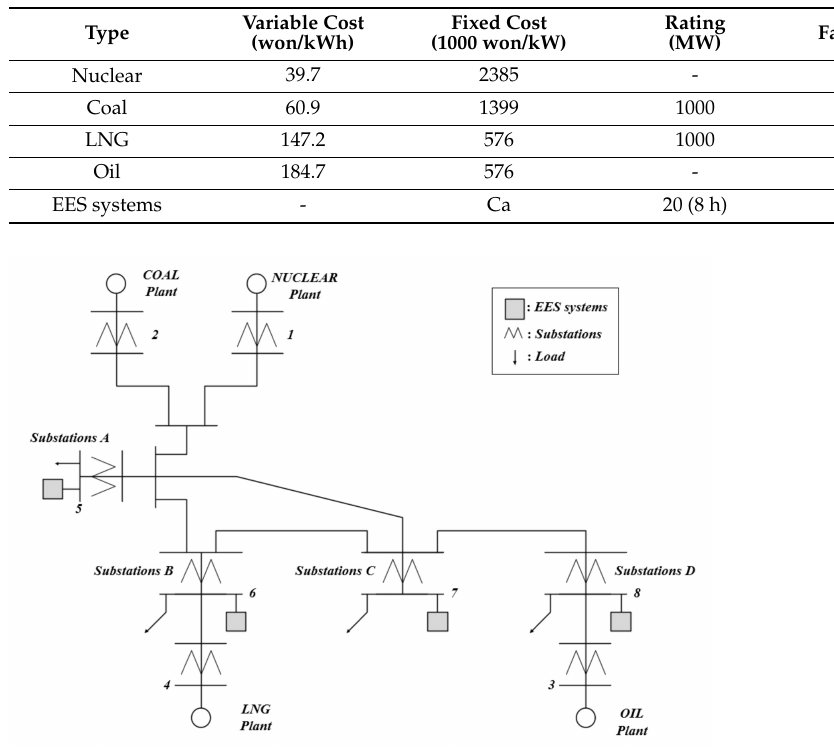
Figure 4. Model power